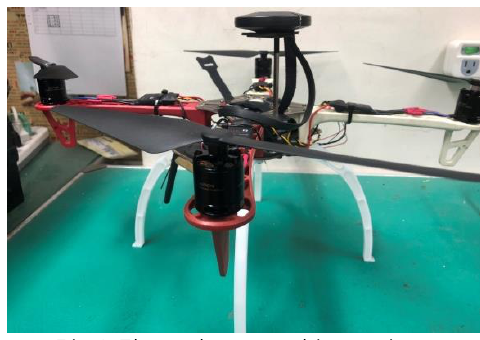
Fig. 1. The quadcopter used in